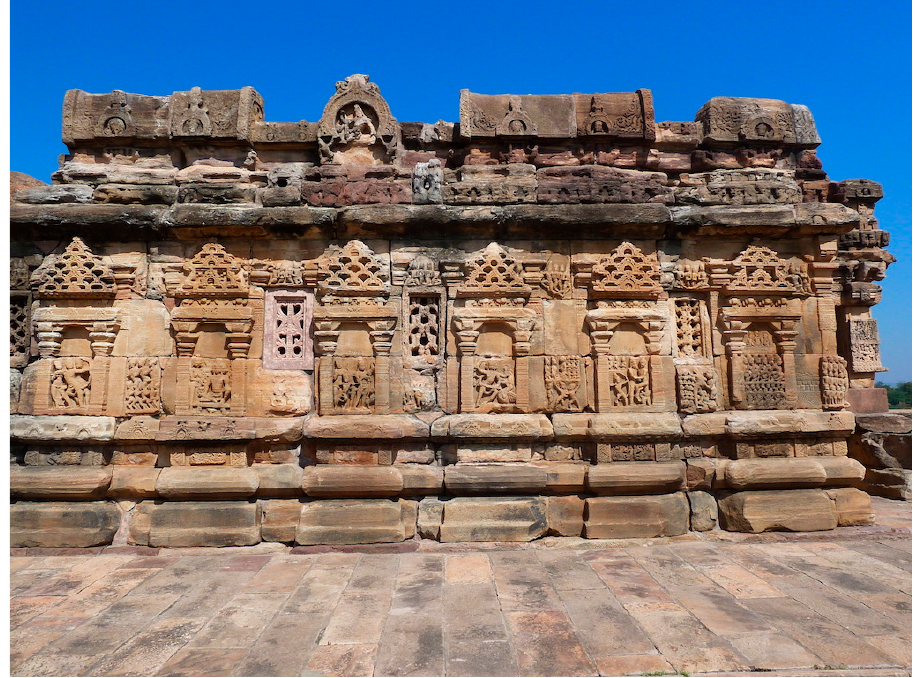
Figure 1. Ramayana sculpture, southern elevation, Papanatha Temple, Pattadakal, Karnataka, India, ca. 8th century CE. Photo: Caleb Smith.